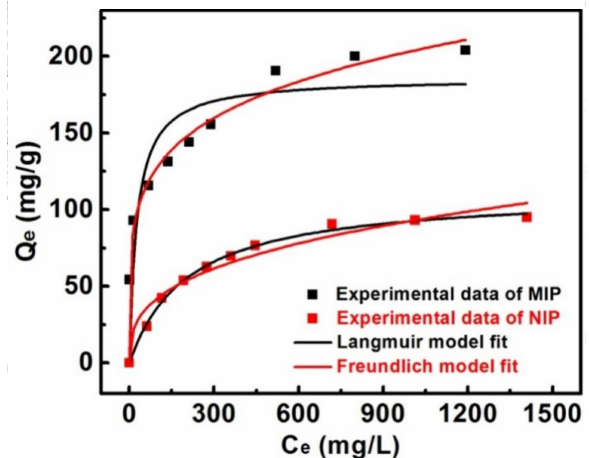
Figure 6. Adsorption isotherms of gossypol binding onto MIP and NIP prepared on the spherical silica 60 µ m (10 mg of absorbents in 5.0 mL gossypol solution for 6 h). Langmuir (Equation (7)) and Freundlich (Equation (8)) isotherm models [48,49] are widely